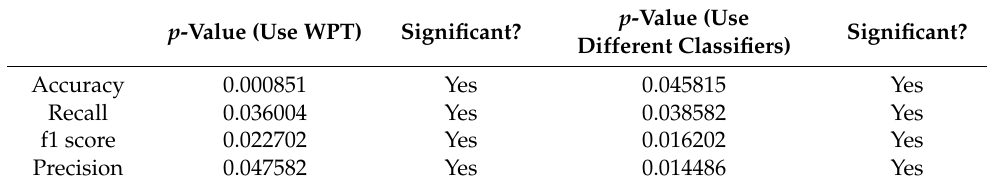
Table 5. Significance test of experimental